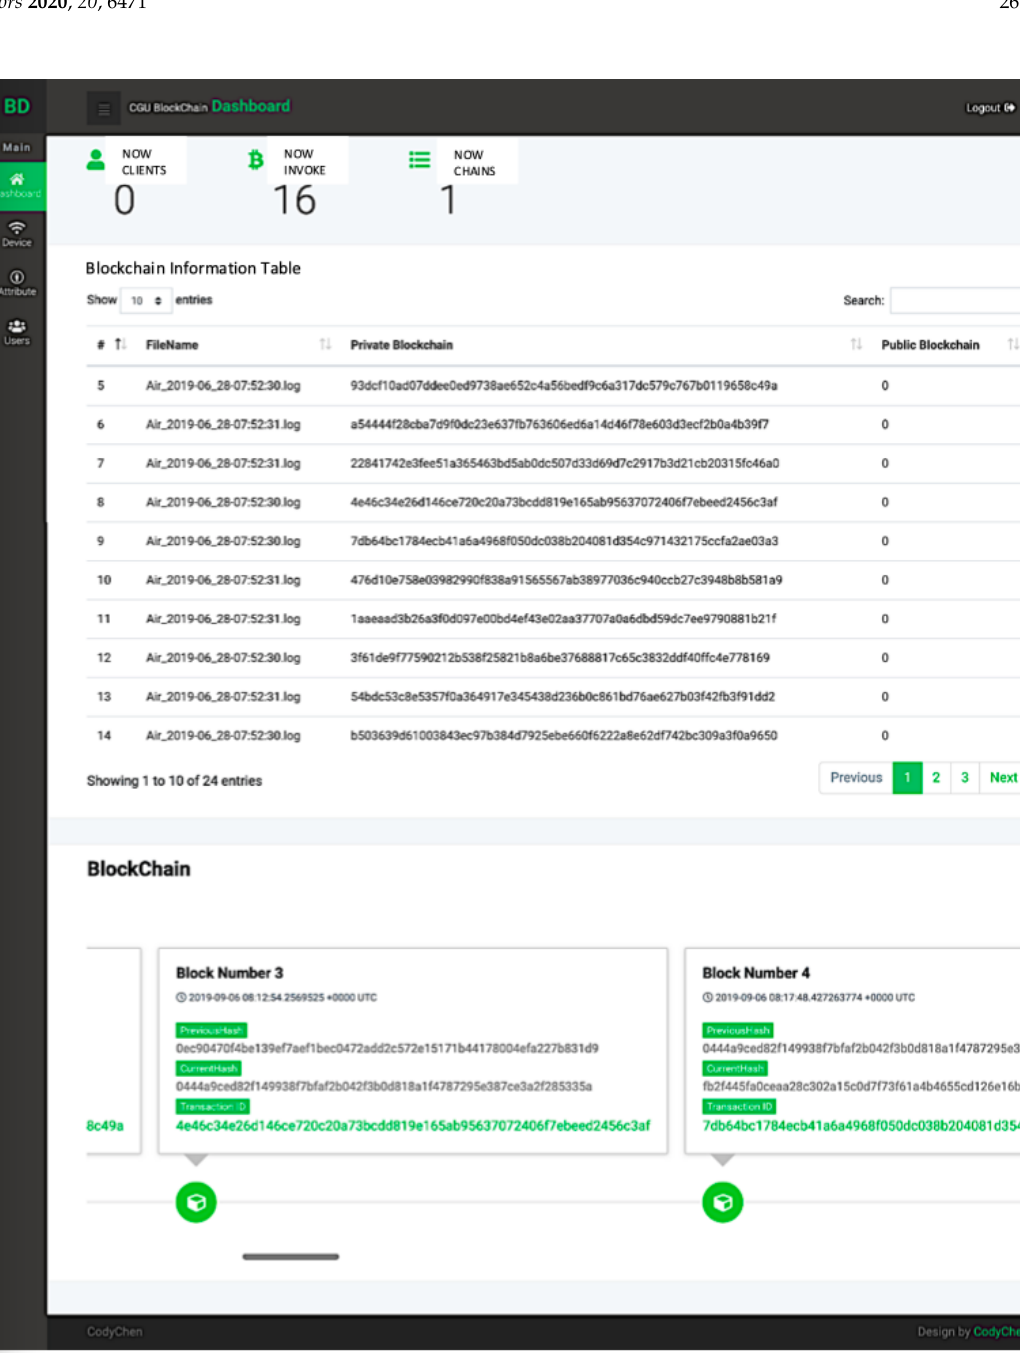
Figure 2. This is a figure. Figure 14. Blockchain server management